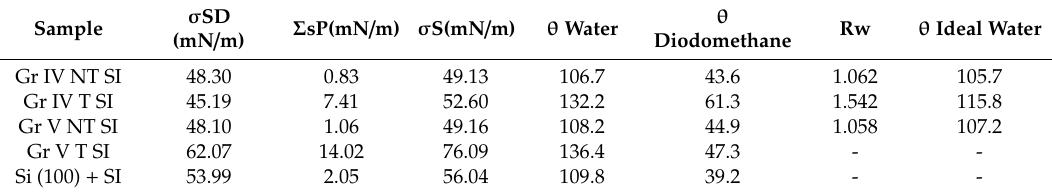
Table 9. Surface tensions and contact angles of the samples with TiO 2 coating. (GR IV: Titanium grade